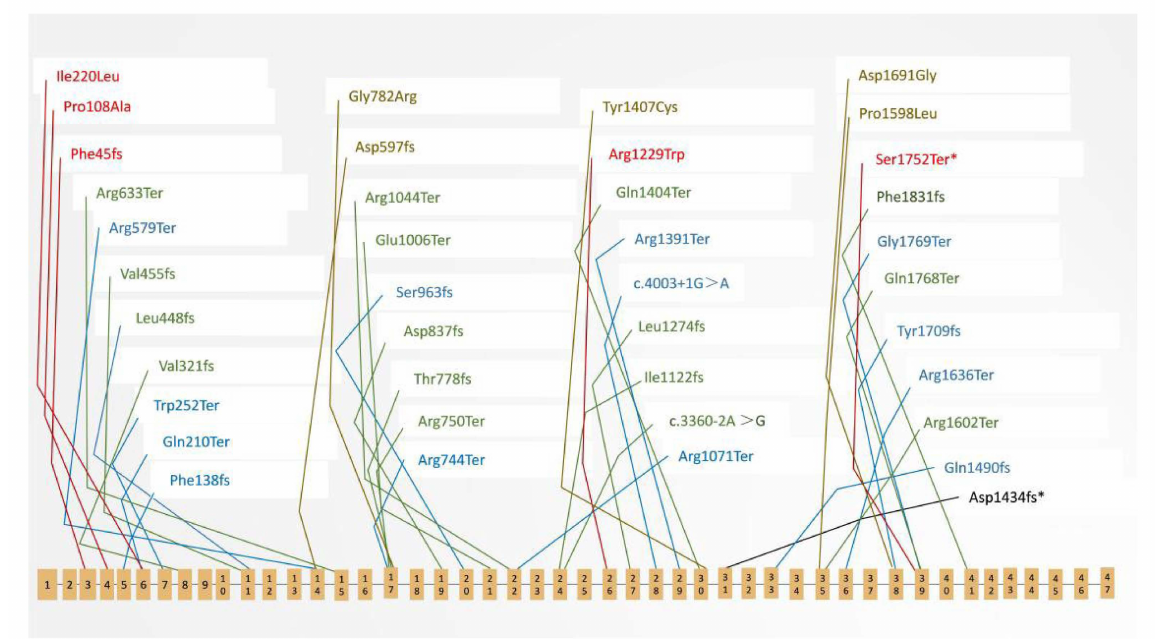
Figure 5. MPDZ pathogenic variations in humans. Schematic representation of the human MPDZ protein showing the distribution of variations. Blue represents a variation related to the hydro- cephalus phenotype in Clinvar (https://www.ncbi.nlm.nih.gov/clinvar/, accessed on 20 August 2022). Green indicates that the pathogenic condition of the variation was “not provided” in Clinvar. Red and brown indicate that the variation was reported with the phenotype of retinitis pigmentosa (RP) and Leber congenital amaurosis (LCA), respectively. Asterisks denote variants related to macular coloboma (MC) in the present